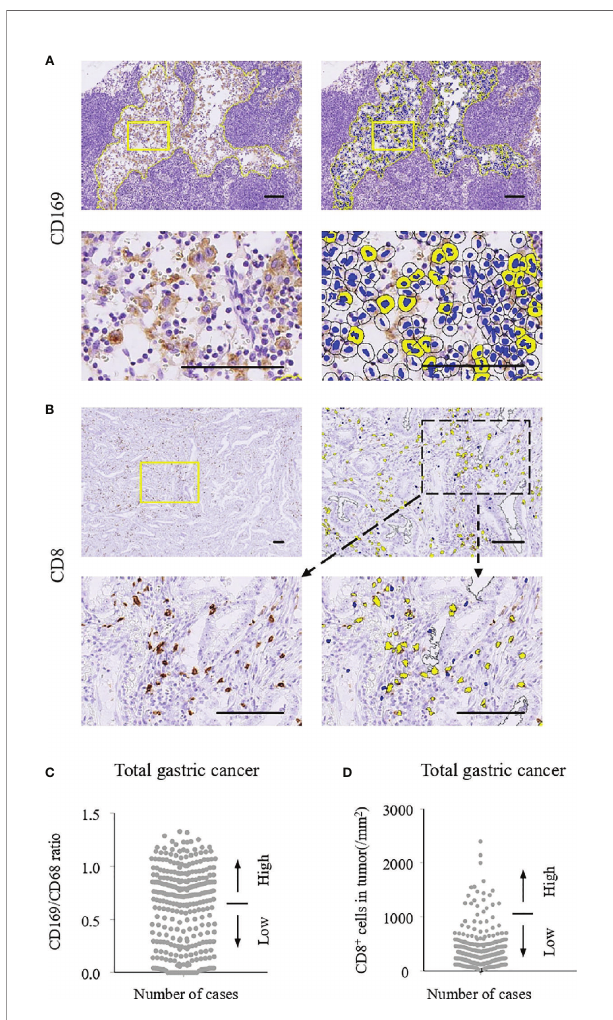
FIGURE 1 | Immunohistochemistry and cell counting system. The numbers of CD169 + and CD68 + cells in regional lymph nodes (RLNs) and CD8 + cells in tumors were evaluated using HALO 2.3 as described in Materials and Methods. Scale bar = 100 m m. Representative immunohistochemistry (IHC) stains of CD169 (A) and CD8 (B) are shown. Positive cells in selected areas surrounded by yellow lines were counted automatically by HALO 2.3. (C) Number of CD169/CD68 ratio in lymph node sinus macrophages (LySMs). (D) Number of CD8 expressions in primary tumor. Patients were divided into two groups according to their CD169/CD68 ratio: < 0.65 was de fi ned as low and ≥ 0.65 was de fi ned as high. With regard to CD8 + cells, the patients were divided into two groups according to cell density: < 287/ mm 2 was de fi ned as low and ≥ 287/mm 2 was de fi ned as